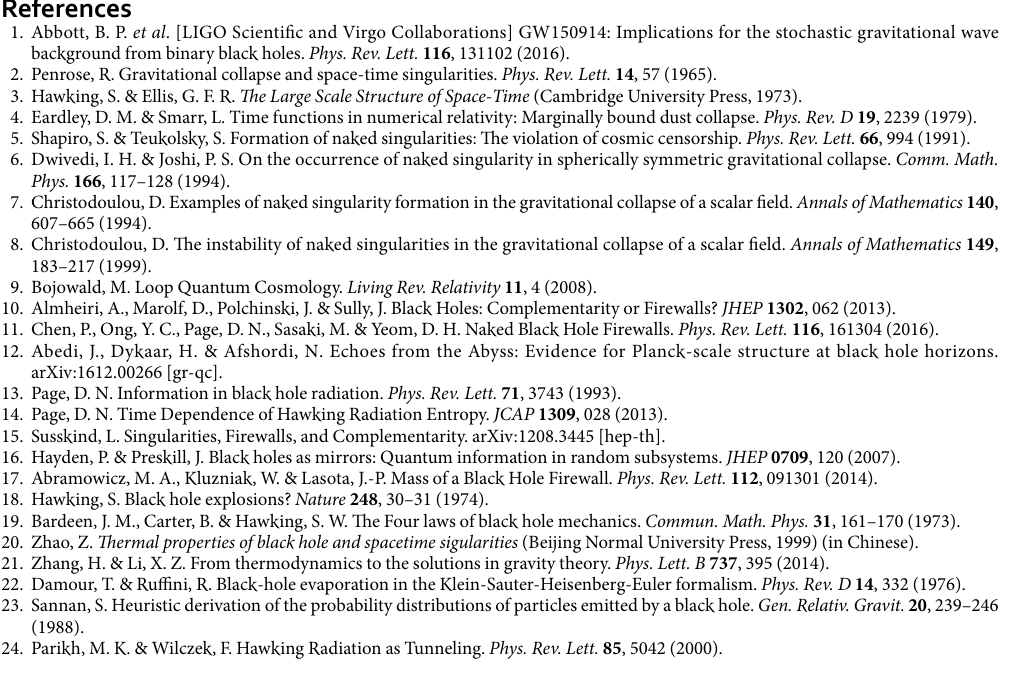
5 Scientific RepoRts | 7: 4000 | DOI:10.1038/s41598-017-03854-y